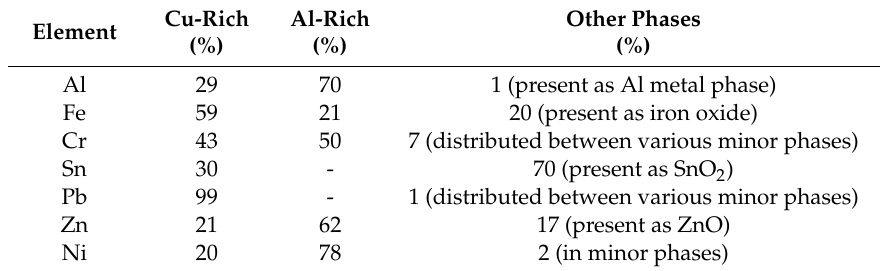
Table 9. Deportment of various elements between the Cu-rich, Al-rich, and other phases in samples M and S.